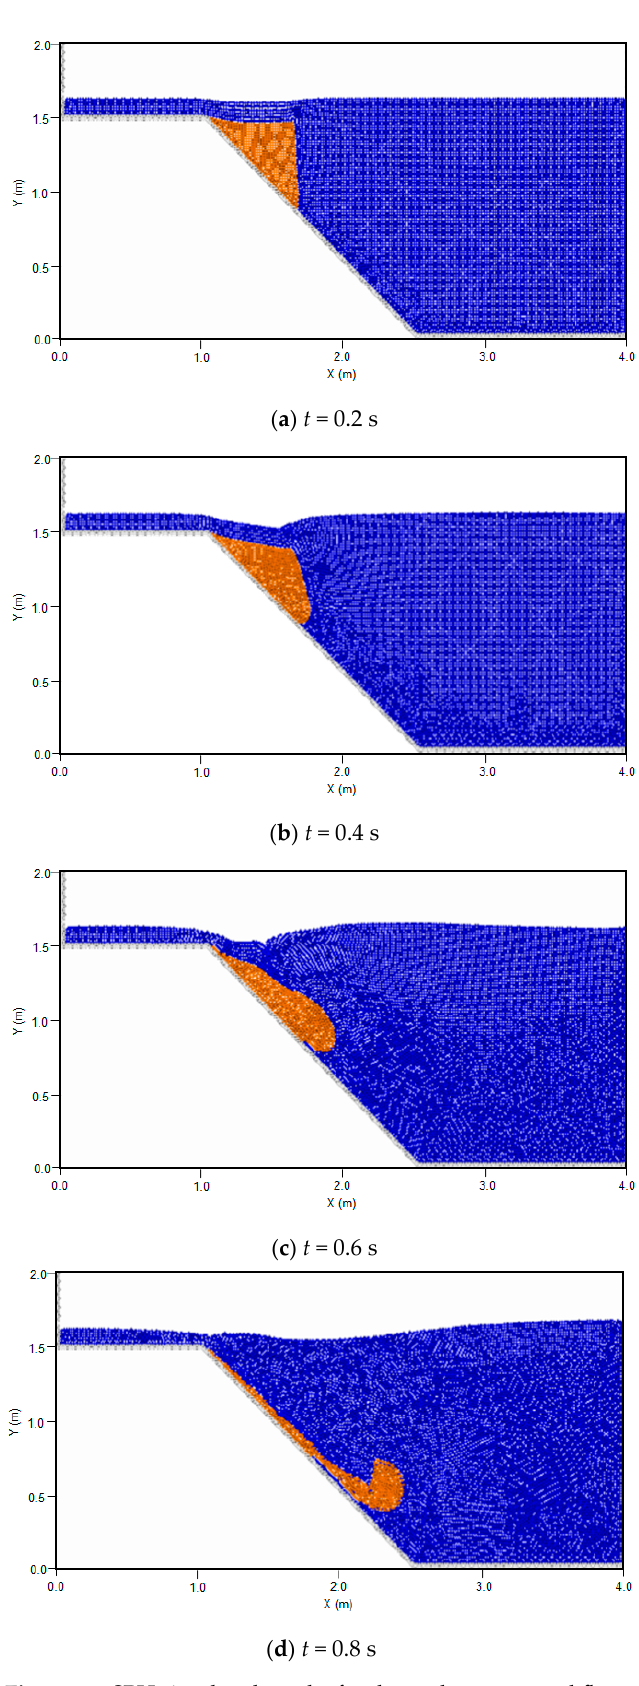
Figure 10. SPH simulated results for the underwater sand flow: ( a ) t = 0.2 s; ( b ) t = 0.4 s; ( c ) t = 0.6 s; ( d ) t = 0.8 s. Table 4. Correlation coefficients between the experimental and numerical results on the water pro- files.